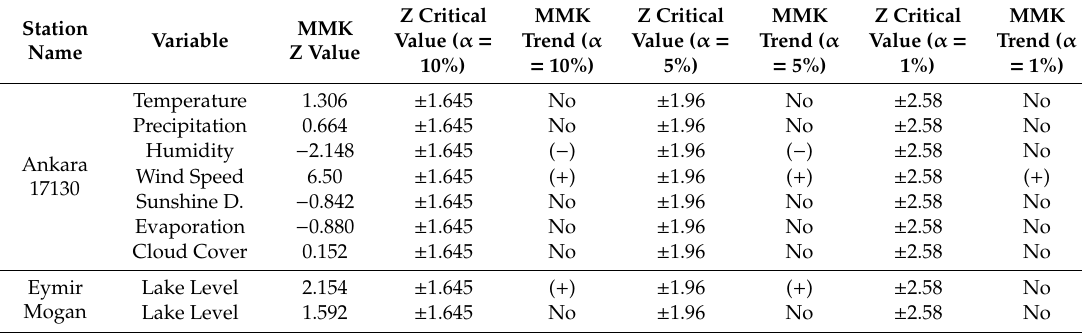
Table 4. Results of the MMK